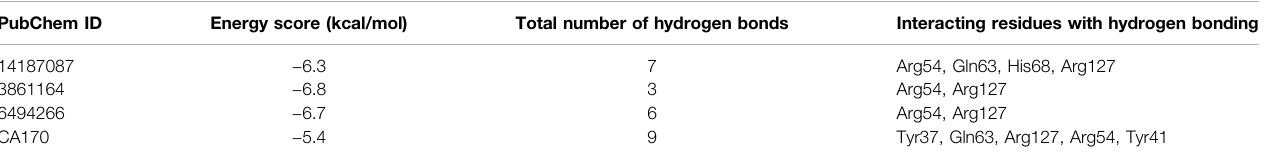
TABLE 1 | Filtered best af fi nity binders of VISTA. The binding af fi nity score, total number of hydrogen bonds, and VISTA residues involved in hydrogen bonding with the compound. PubChem